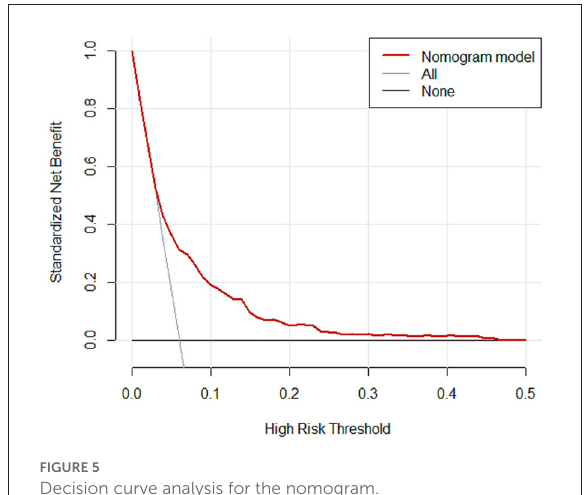
FIGURE5 Decision curve analysis for the